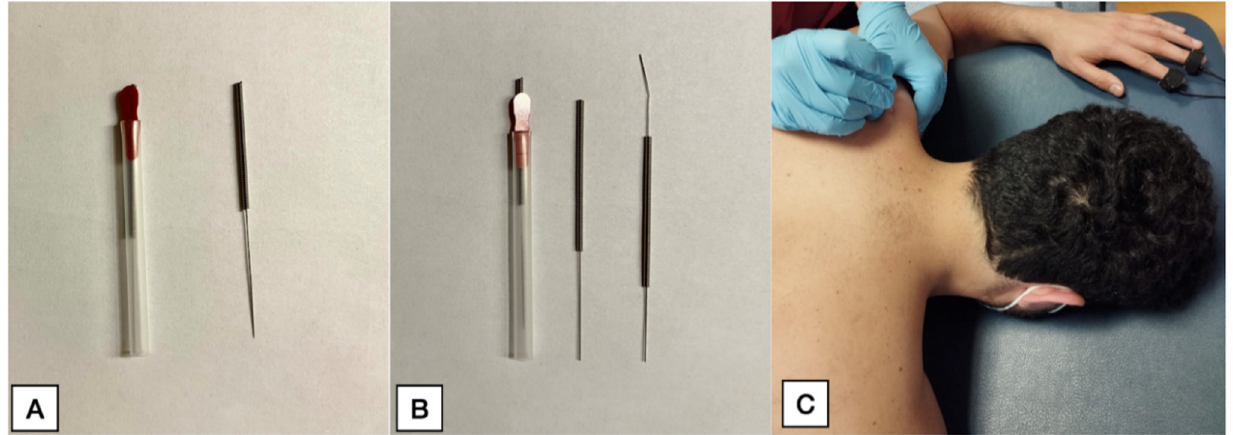
Figure 2. Real needles ( A ). Sham needles ( B ). Application of either needling intervention ( C